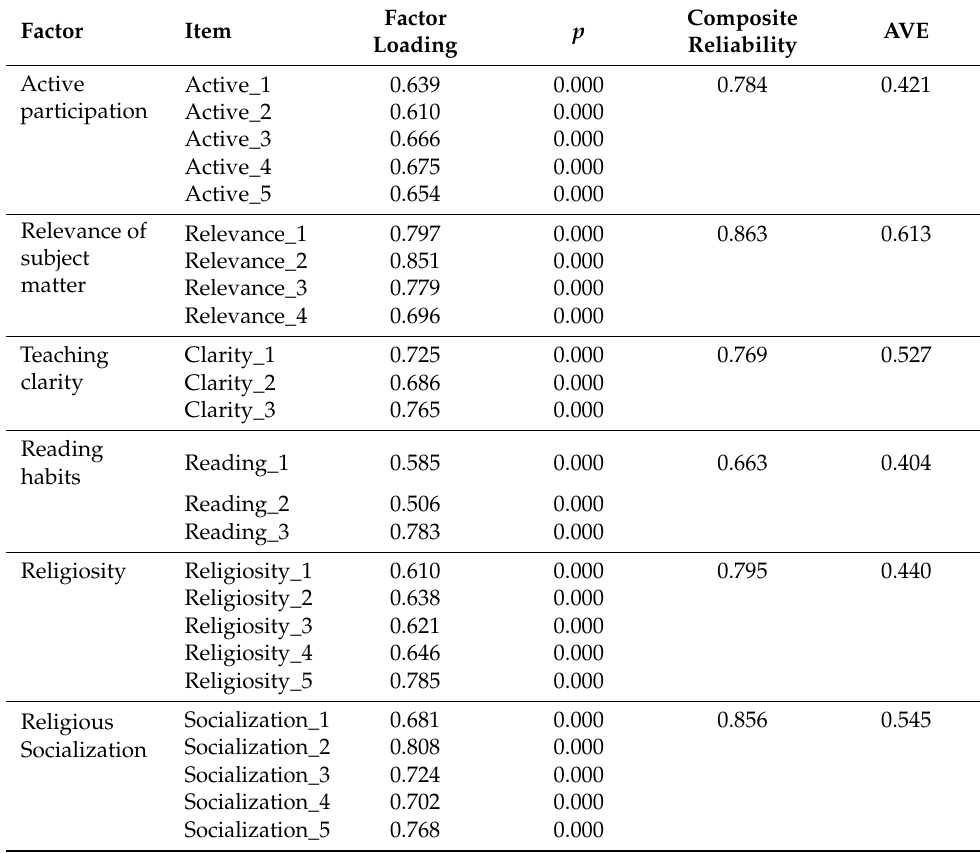
Table A2. Confirmatory factor analyses of the scales included in the structural equation